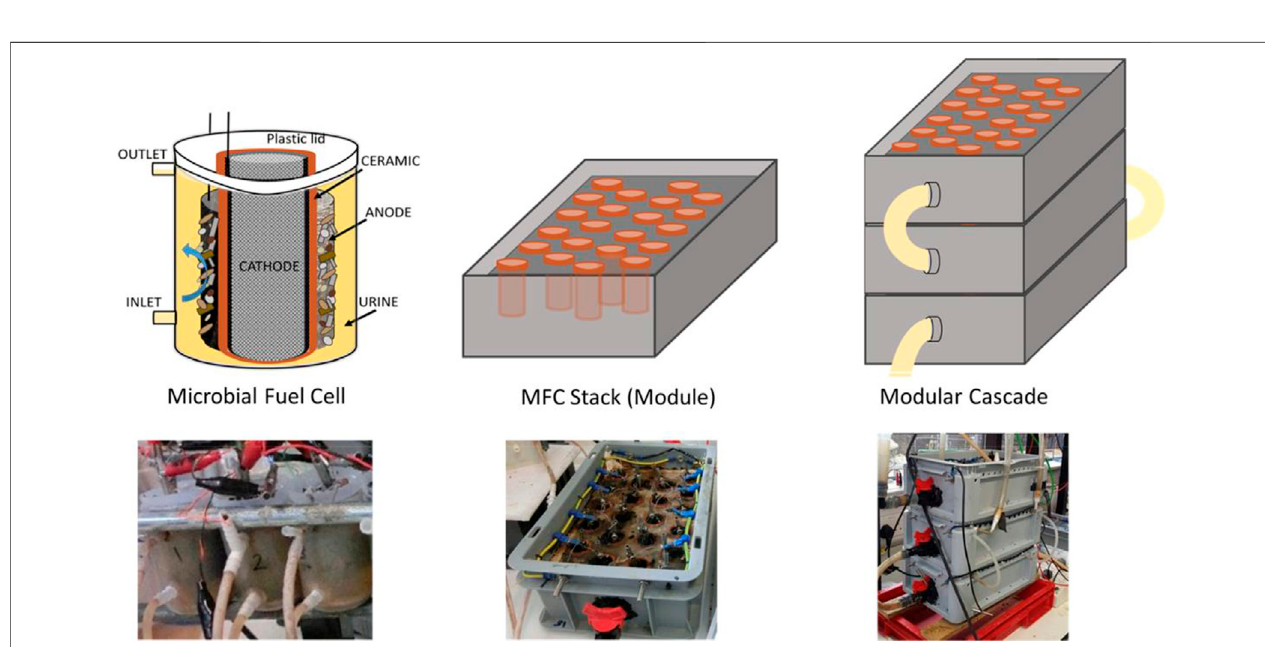
FIGURE 4 | (i) Individual MFCs (triplicate), (ii) those assembled in a 22-MFC module (stack), and (iii) those in a 3-module cascade (Gajda et al., 2020).